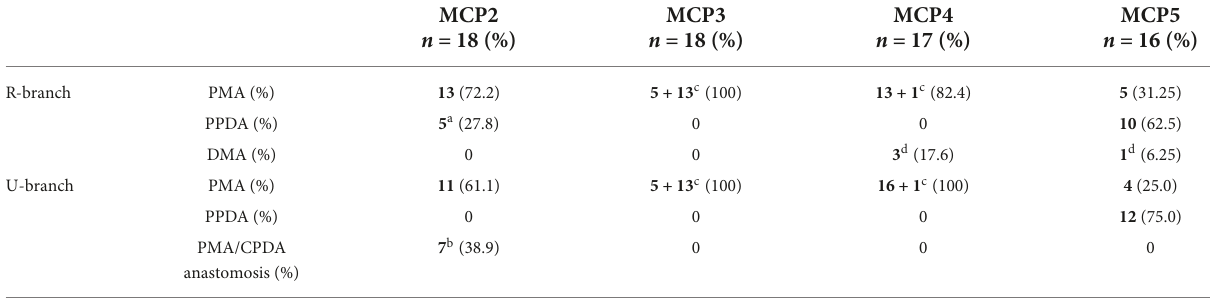
TABLE 2 Varying origins of the radial and ulnar branches based on